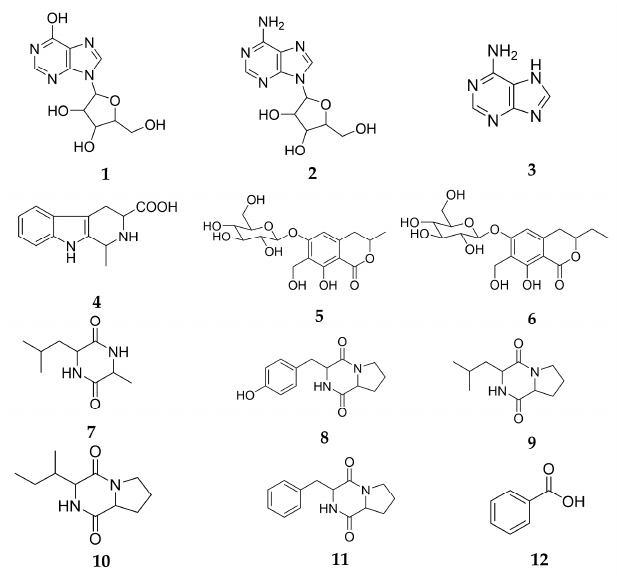
Figure 1. Structures of compounds 1–12.